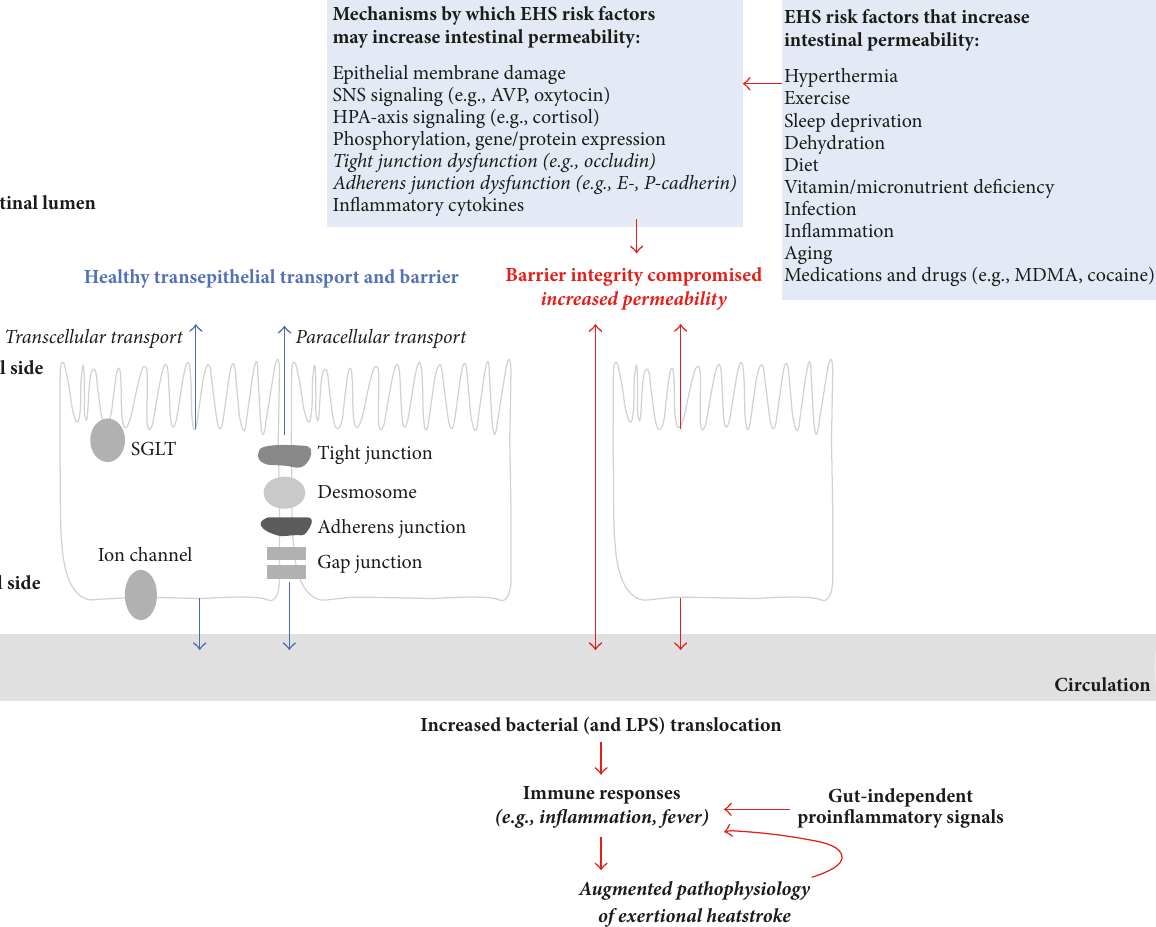
Figure 5: An intact intestinal epithelium allows efficient transepithelial transport across cells (transcellular transport) and between cells (paracellular transport) via (1) channels directly embedded in the membrane such as SGLT (sodium-dependent glucose transporter), ion channels, and aquaporins and (2) control of gap junctions, adherens junctions, desmosomes, and tight junctions between epithelial cells. EHS risk factors including hyperthermia, exercise, dehydration, sleep deprivation, drugs, and diet are known to increase intestinal permeability via multiple independent mechanisms. When intestinal barrier integrity is compromised, increased permeability results in bacterial or endotoxin translocation into circulation. Bacterial components may stimulate an immune response that results in signaling that promotes positive feedback of inflammation and inflammation-associated symptoms such as fever. Simultaneously, stress or tissue injury also may signal to enhance proinflammatory immune responses via gut-independent signals such as DAMPs (danger-associated molecular patterns) including heat shock protein 60, which are increased during cell/tissue stress. SNS, sympathetic nervous system; AVP, arginine vasopressin; HPA,